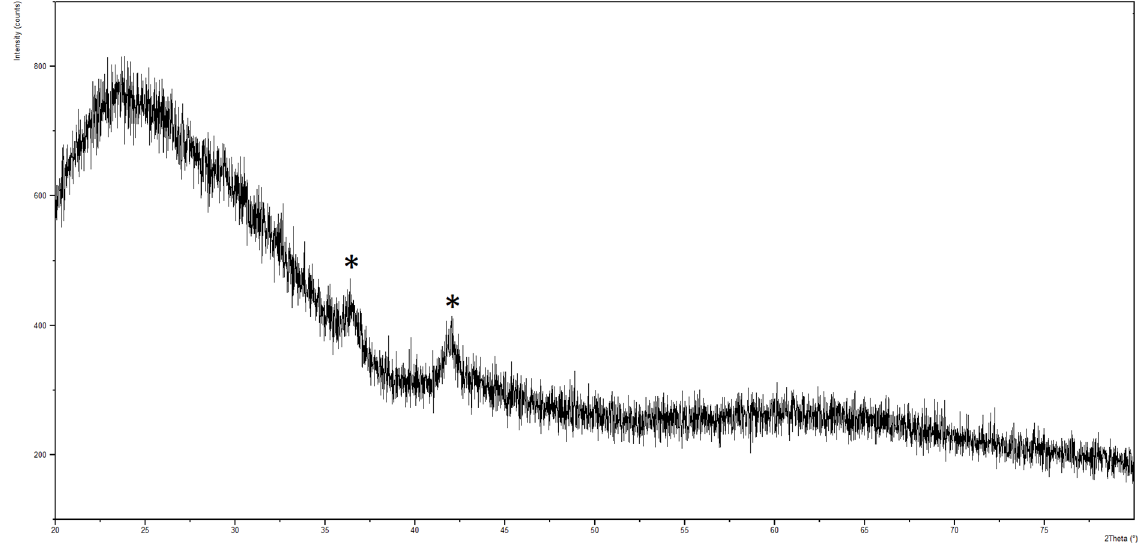
Figure 2. XRD spectrum of copper-based films. Peaks relative to copper oxide (Cu 2 O, ICDD 00-005-0667) are marked with *.